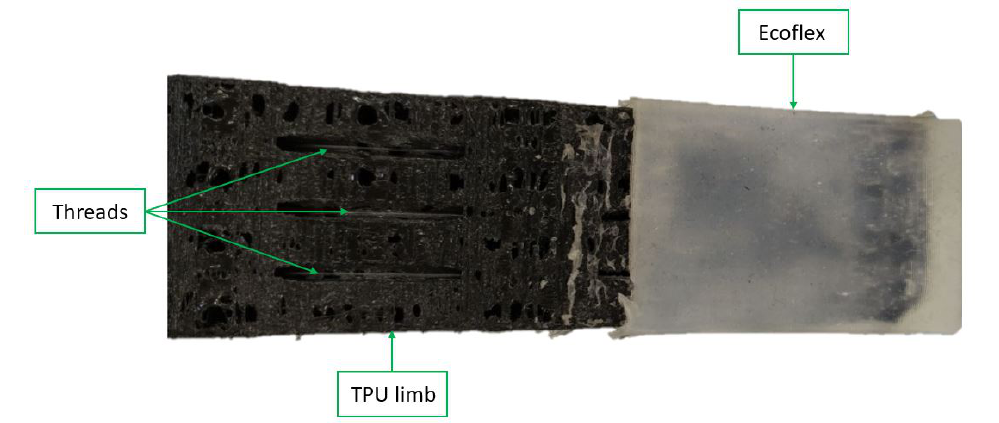
Figure 9. The final result when joining TPU with ecoflex. It can be seen that ecoflex is only applied to the tip to increase the adhesion in this